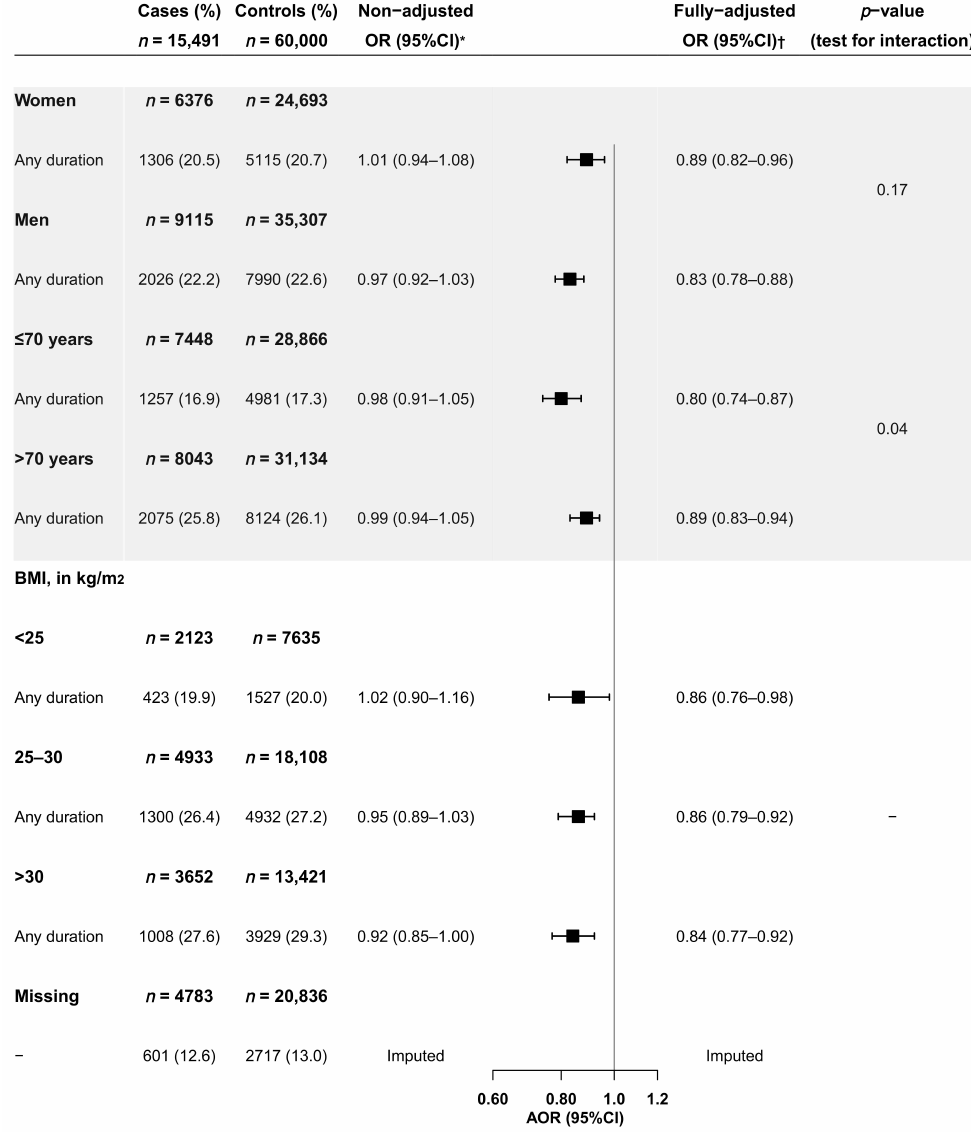
Figure 2. Current use of statins and risk of colorectal cancer, by gender, age and body mass index (BMI). BMI: body mass index; OR: odds ratio; CI: confidence interval * Model adjusted only for matching variables (age, sex, and calendar year). The category of reference was “non-use of statins”. † Model adjusted for: (1) Matching variables: age, sex and calendar year, (2) Comorbidities and risk factors: number of visits in the last year, BMI, alcohol abuse, smoking, chronic gastritis, reflux, inflammatory bowel disease, irritable bowel syndrome, constipation, anorectal pathology, upper GI disorders, lower GI bleeding, hyperuricemia and gout, and (3) Use of drugs: antihypertensives, low-dose aspirin, non-aspirin antiplatelet drugs, oral anticoagulants, glucose-lowering drugs (oral and insulin), other lipid-lowering drugs, anti-H2 acid suppressors, proton pump inhibitors, antidiar- rheal drugs, drugs for constipation, selective serotonin reuptake inhibitors and serotonin receptor antagonists with serotonin reuptake inhibition, analgesic opioids, NSAIDs (non-selective and coxibs), SYSADOAs, calcium and vitamin D supplements, and